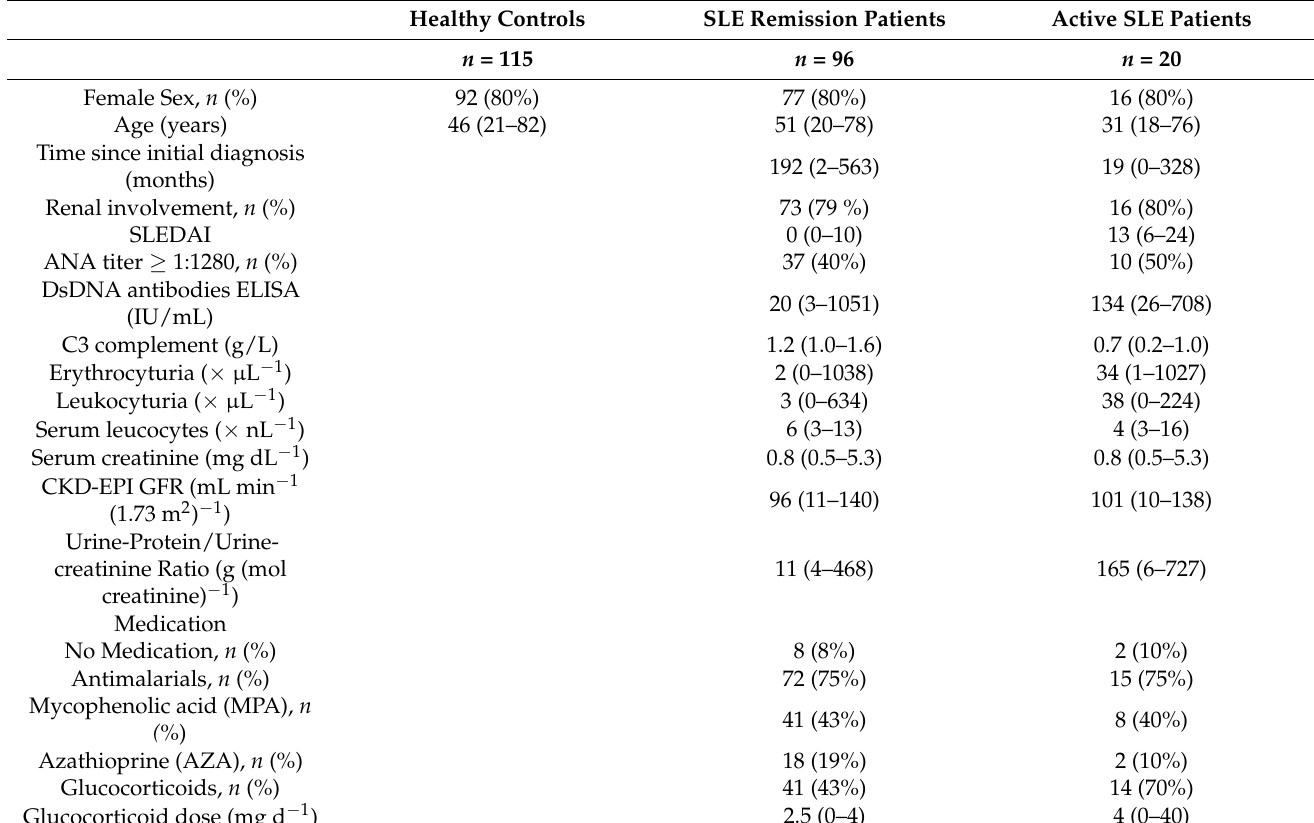
Table 1. Clinical characteristics of SLE patients and healthy